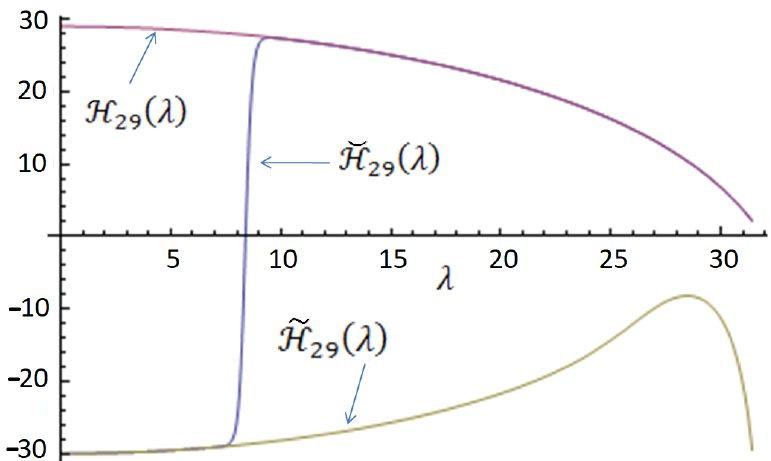
Figure 4. The driving terms of the three stochastic representations for m = 29. The geometrical parameters were selected as k η = π and e 29 = 10 π . Then, according to the rule (63), the radial function g 29 has the form g 29 ( λ ) = 1.41 × 10 25 j 29 ( λ ) − y 29 ( λ )